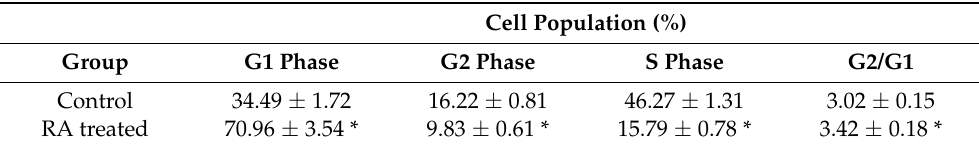
Figure 9. SHSY-5Y cells are differentiated into neuron-like cells by retinoic acid treatment: ( A ), negative control; and ( B ), 10 µM of all trans RA applications for 11 days.